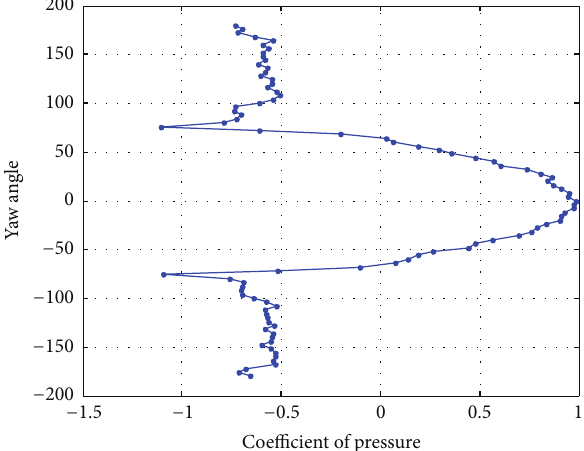
Figure 7: Nonuniqueness of the yaw angle prediction problem at 120 fps with one pressure